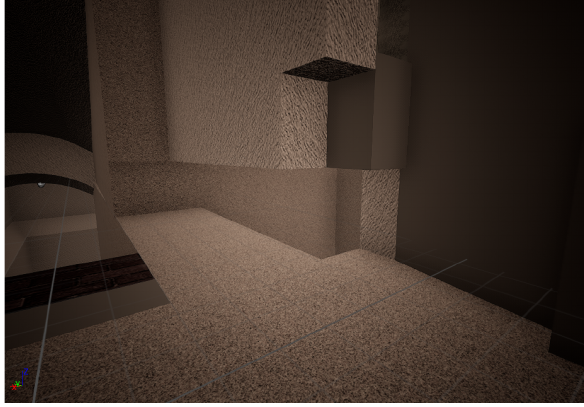
Figure 6 . Example of error - missing part of masonry. The built-in clock (Fig. 7) is modelled as a general Revit family model consisting of custom clock hands as well as specific font of clock dial. However, the material definition error occurs as the clock face is modelled transparent. The hands of the clock seem to levitate in the air.